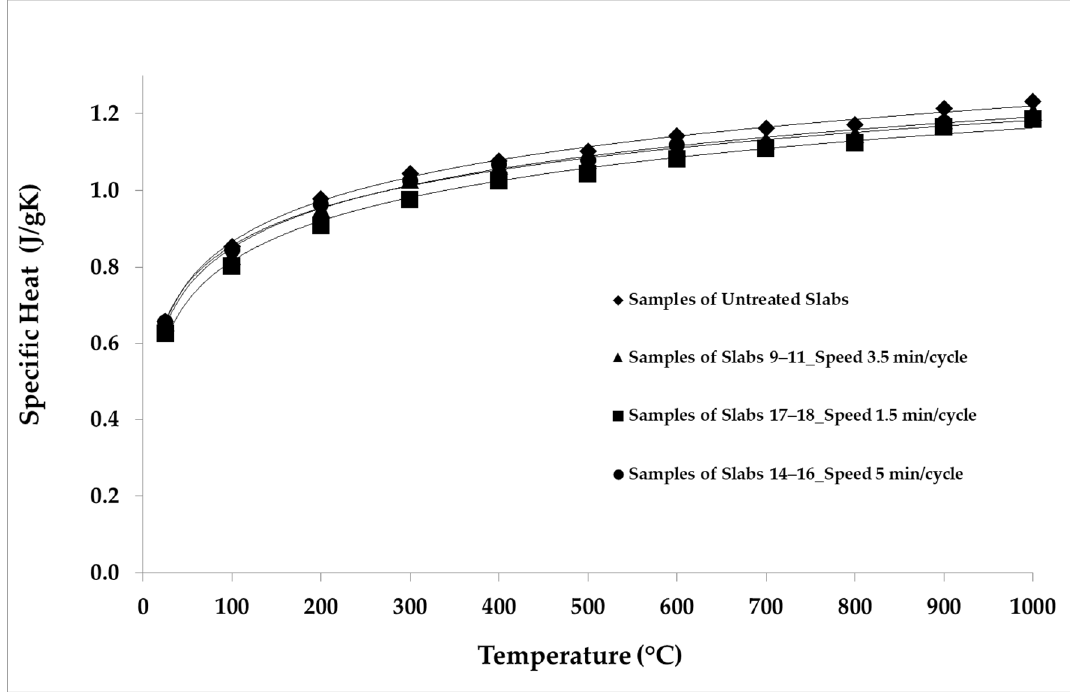
Figure 9. Specific heat values considering different speed of thermal cycles.